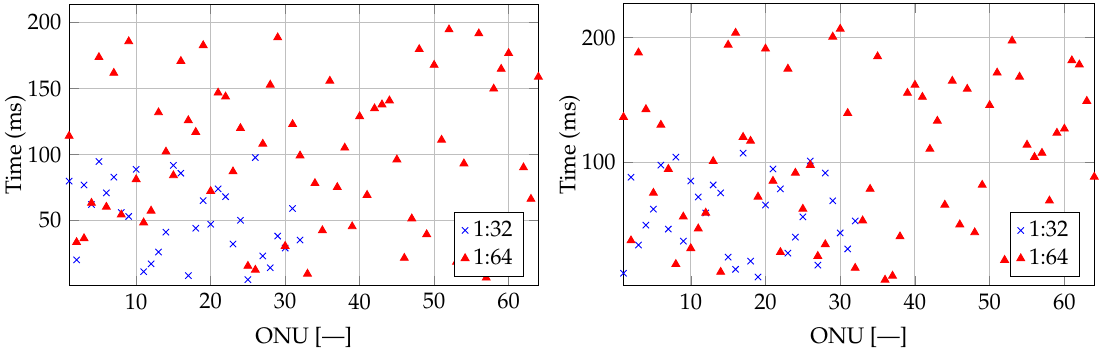
Figure 8. Graph of activation time for XG-PON ( left ) and NG-PON2 ( right ) 32/64 units and 20-km ODN.